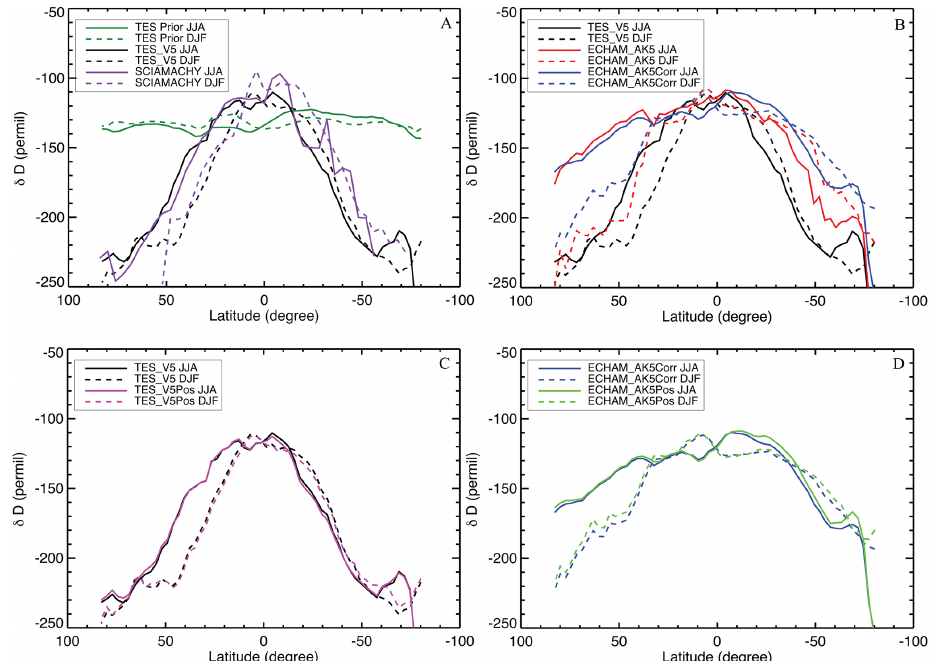
Figure 4. Seasonal comparison of zonal means of δ D from TES prior, TES V5 , and SCIAMACHY (a) ; from TES V5 , ECHAM AK5 , and ECHAM AK5Corr (b) ; from TES V5 and TES V5Pos (c) ; and from ECHAM AK5Corr and ECHAM AK5Pos (d) . Solid lines show NH summer profiles and dashed lines NH winter profiles. All figures are weighted averaged between 900 and